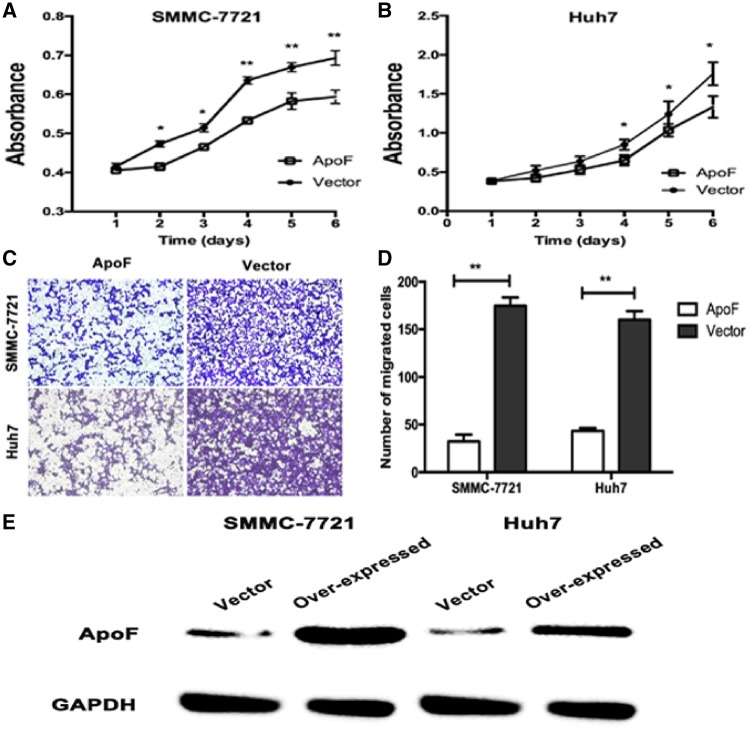
ApoF overexpression affects cellular proliferation and migration In vitro. (A) and (B) Representative images showing the inhibition of cell proliferation in vitro after ApoF overexpression, as analysed with CCK-8 assay. (C) and (D) Transwell migration of SMMC-7721 and Huh7 cell lines stably transfected with ApoF or empty vector (with cells exhibiting migration indicated in the histogram). (E) Western blot analysis to detect ApoF expression in stable cell lines (SMMC-7721-ApoF and SMMC-7721-vector; Huh7-ApoF and Huh7-vector). GAPDH was used as a loading control.